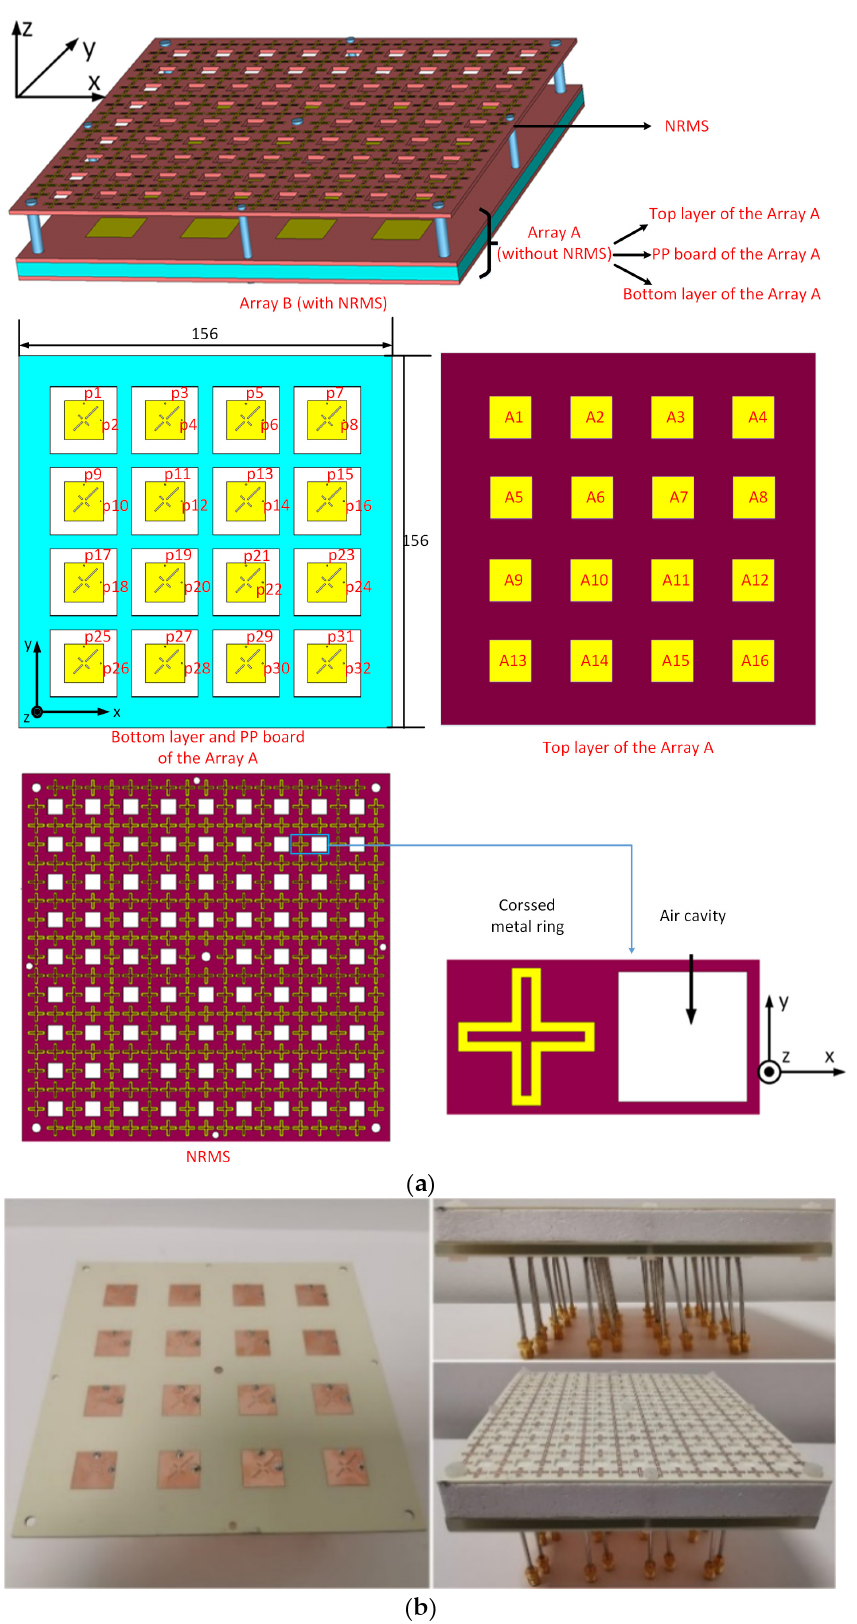
Figure 6. ( a ) the configuration of the original 4 × 4 phased array with NRMS (Array B), (Unit: mm). ( b ) the fabricated prototype of the Array B with feeding cables.